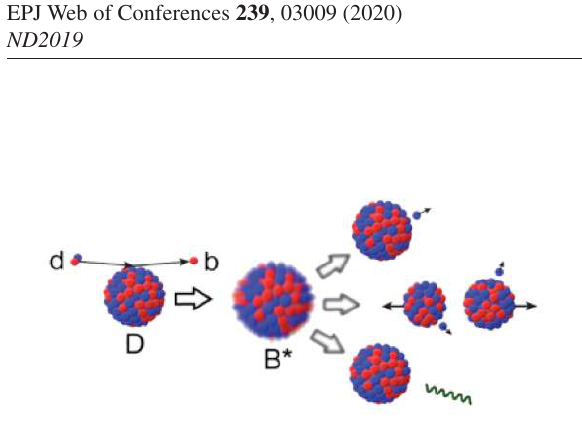
Schematic showing the translation of quantum num- bers used in the two-neutron basis into those required for calcu- lations in the di-neutron pseudo-particle